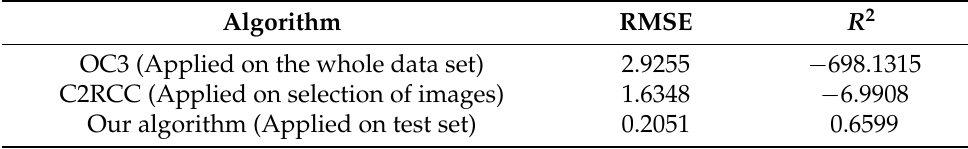
Table 7. Comparison of statistical evaluation indices of OC3, C2RCC, and our algorithm for predicting Chl-a concentration in respect to in situ